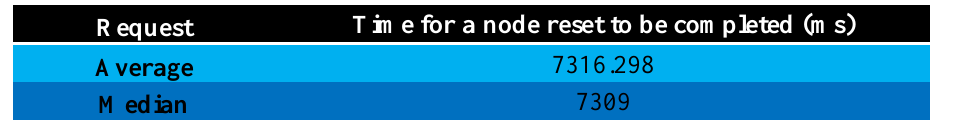
Table 8. Most significant measures obtained for an agent to get re-registered.